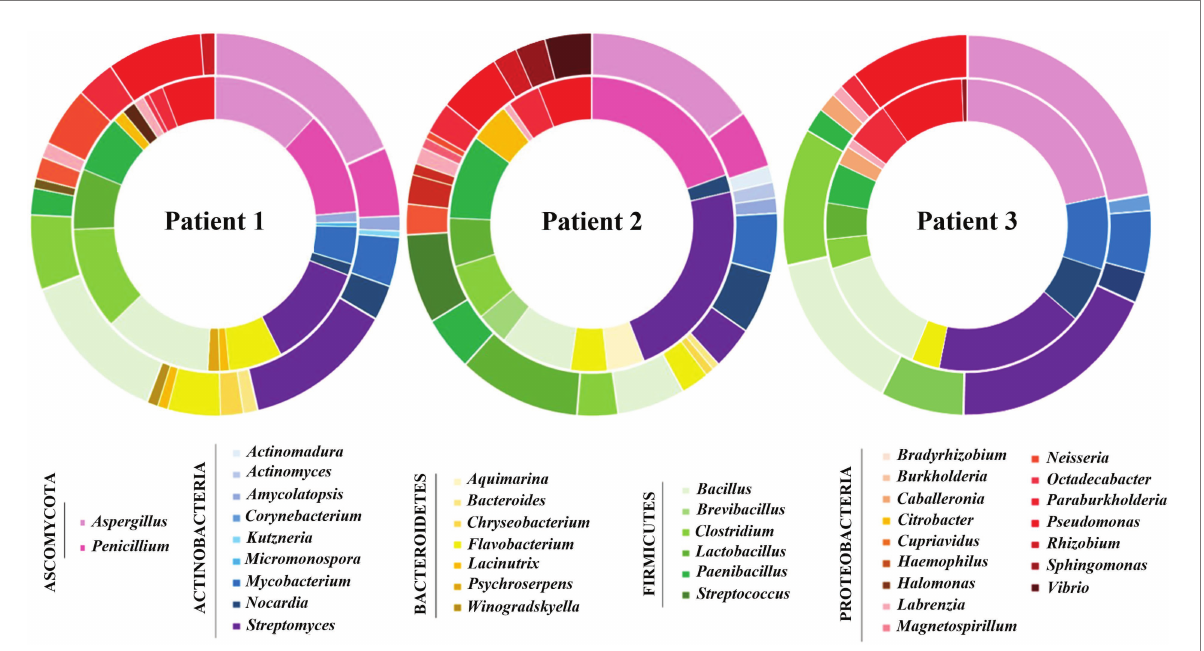
FIGURE 4 Relative abundance of microbial taxa at the genus level in spontaneous sputum (SS) versus induced sputum (IS) samples determined following the mass-exclusion list strategy. The relative abundance (%) corresponds to the normalized TSM signals at the genus level. The inner circle indicates the relative abundance of the microbial taxa found in SS sample whereas the outer circle corresponds to the results for IS sample. Each value corresponds to the mean of the analytical triplicates per